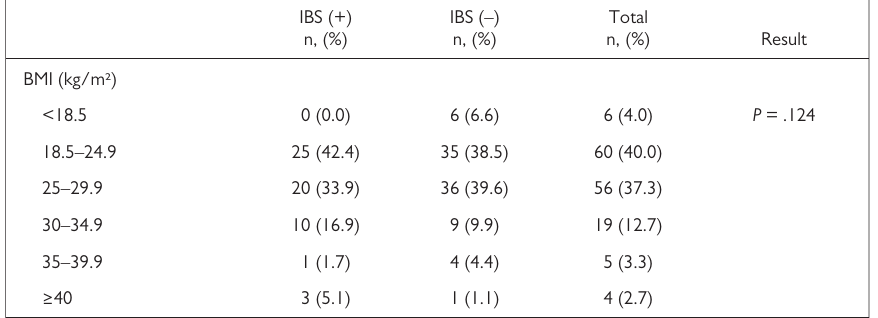
Table 2. Patients ’ Sociodemographic and Clinical Characteristics according to Presence of IBS (Continued)